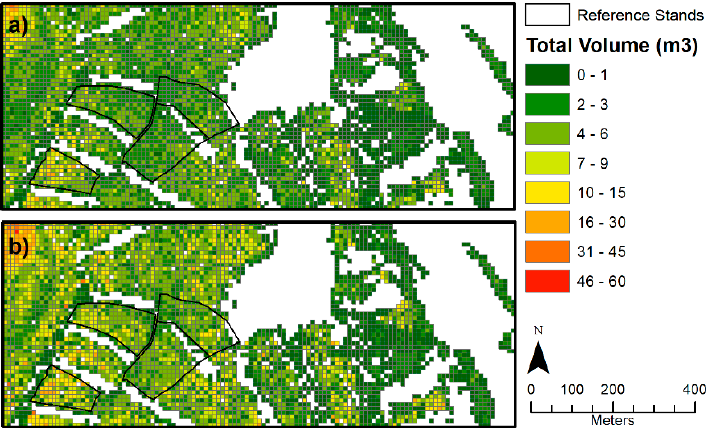
Figure 5. Maps of total volume over grid cell (10 × 10 m): ( a ) Multisource-based method and ( b ) raster-based method.